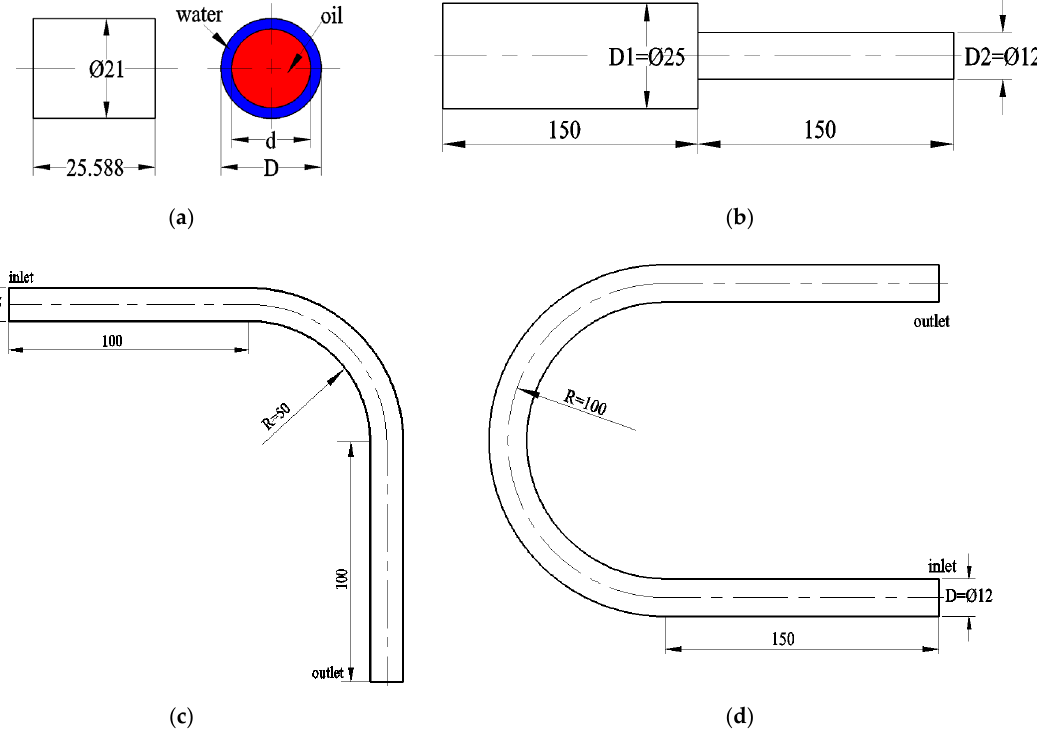
Figure 1. The geometries of pipe structures. ( a ) The straight pipe; ( b ) The sudden-contraction pipe; ( c ) The elbow pipe; ( d ) The return pipe. Table 1. The cells and nodes of flow